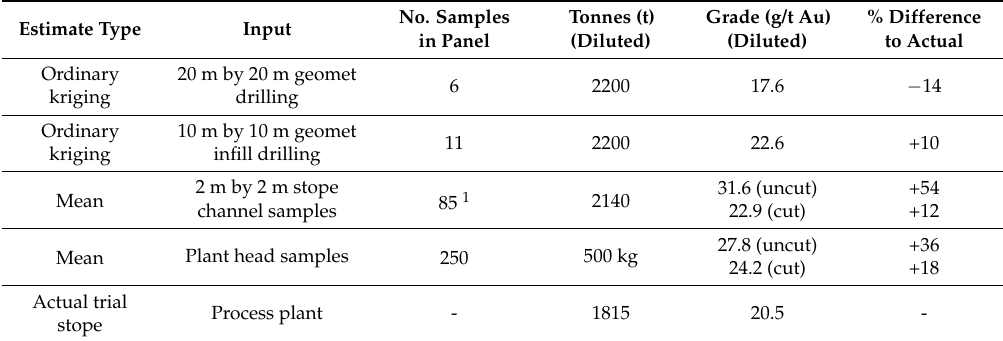
Table 20. Comparison between estimates and actual reconciled trial stope head grade and tonnage.